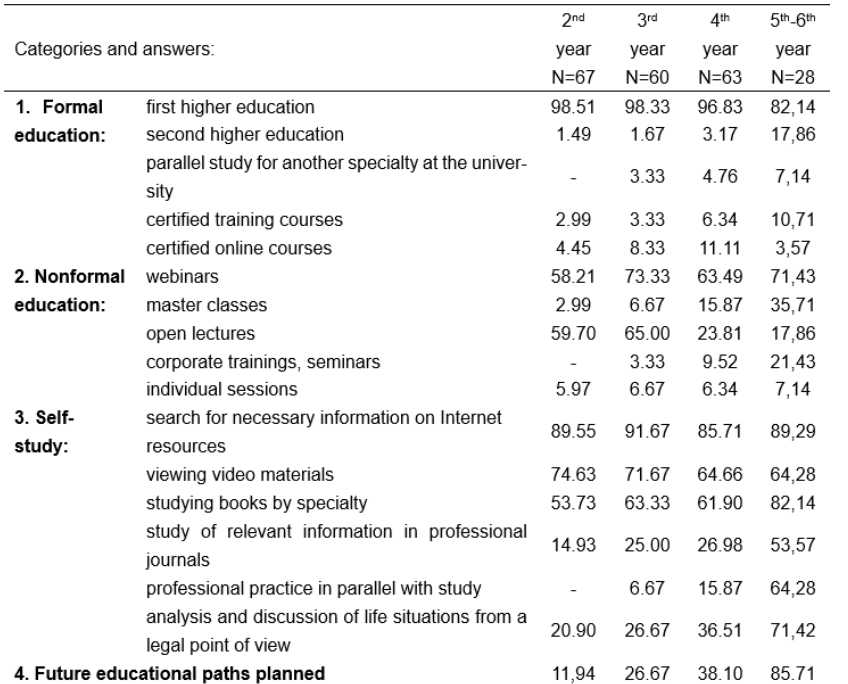
Individual experience of LLL in law students,